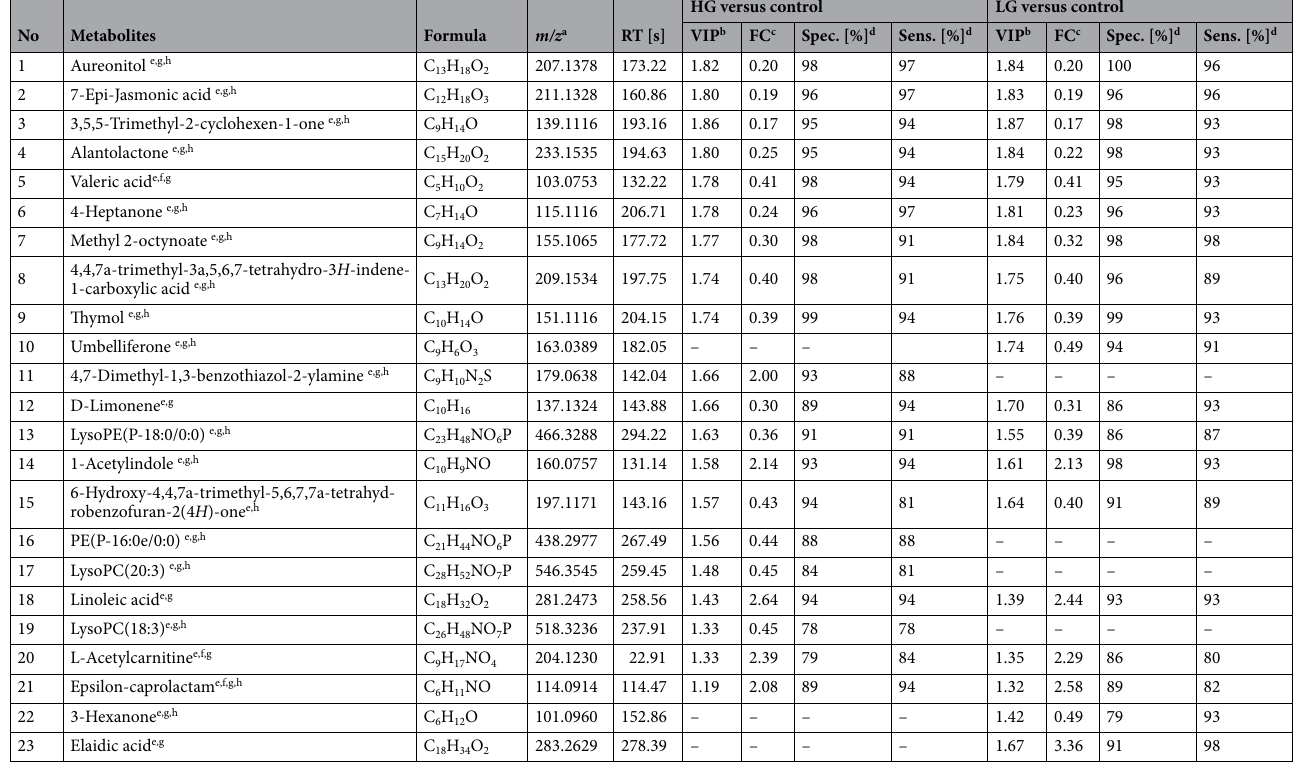
Table 2. Differential metabolites for discrimination between LG and HG BC patients and NCs ( p value < 0.05; FDR < 0.05; VIP > 1; FC < 0.5 and > 2). a Experimental monoisotopic mass; b VIP scores derived from OPLS-DA model; c fold change between cancer and control serum calculated from the abundance mean values for each group—cancer-to-normal ratio; d ROC curve analysis for individual biomarkers; e the metabolites identified by high precursor mass accuracy; f the metabolites identified by matching retention time; g the metabolites identified by matching isotopic pattern; h the metabolites identified by matching MS/MS fragment spectra; AUC: area under the curve; CI: confidence interval; FC: fold change; FDR: false discovery rate; HG: high- grade; LG: low-grade; m/z : mass-to-charge ratio; RT: retention time; Sens.: Sensitivity; Spec.: Specificity; VIP: variable influence on